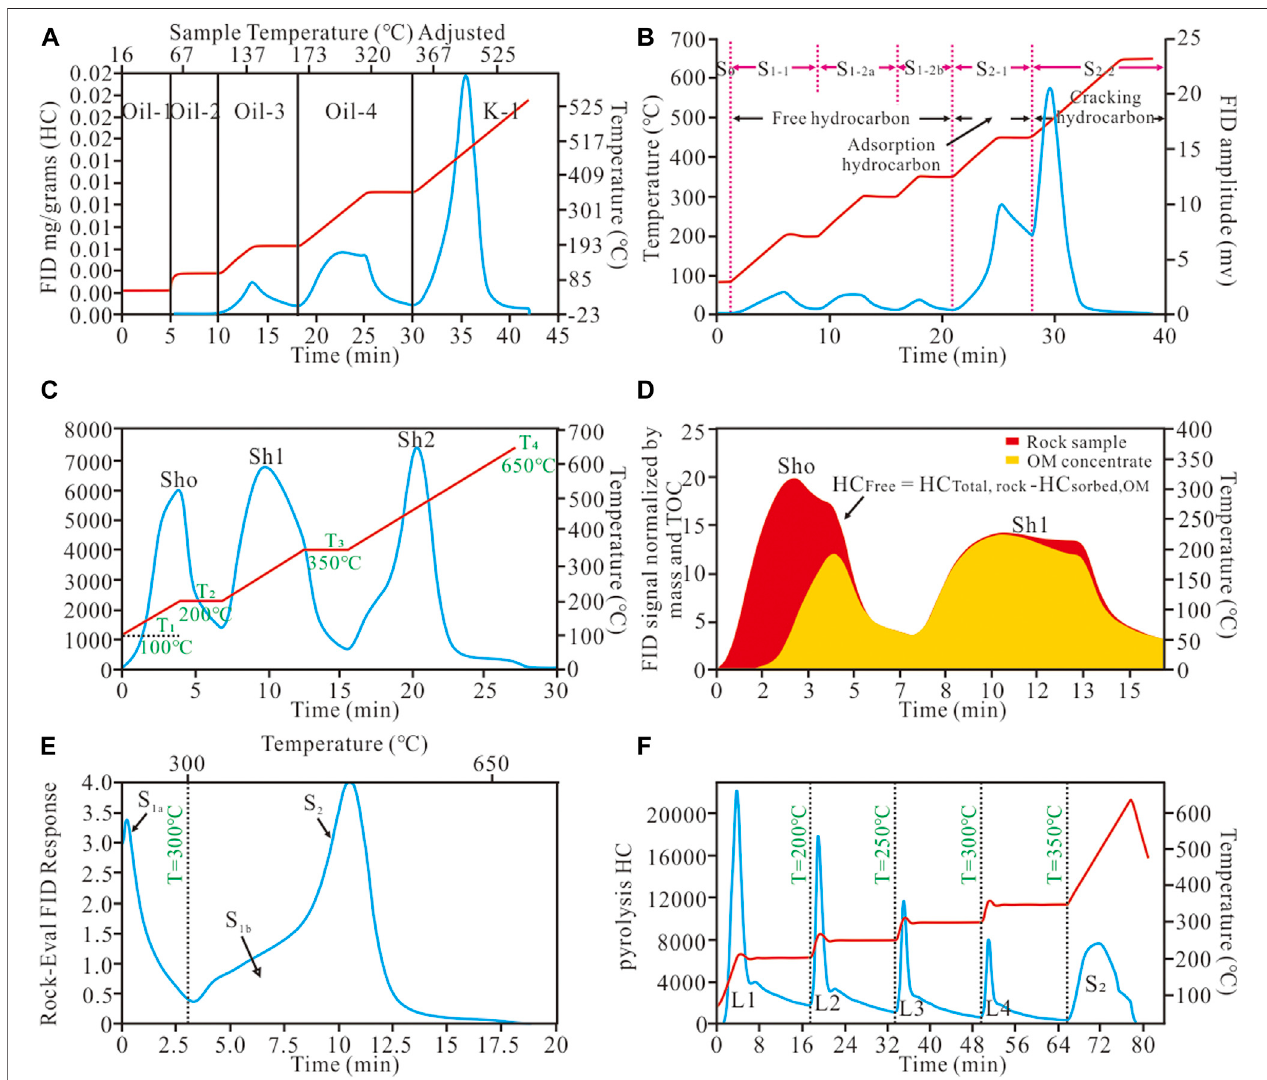
FIGURE8| Aschematicdiagramofmulti-steppyrolysismethod. (A) ismodi fi edfromMaende (2016); (B) ismodi fi edfromLiJ.B.etal.(2020a); (C , D) aremodi fi ed from Romero-Sarmiento (2019); (E) is modi fi ed from Li M. W. et al. (2020); (F) is modi fi ed from Gentzis et al. (2021).